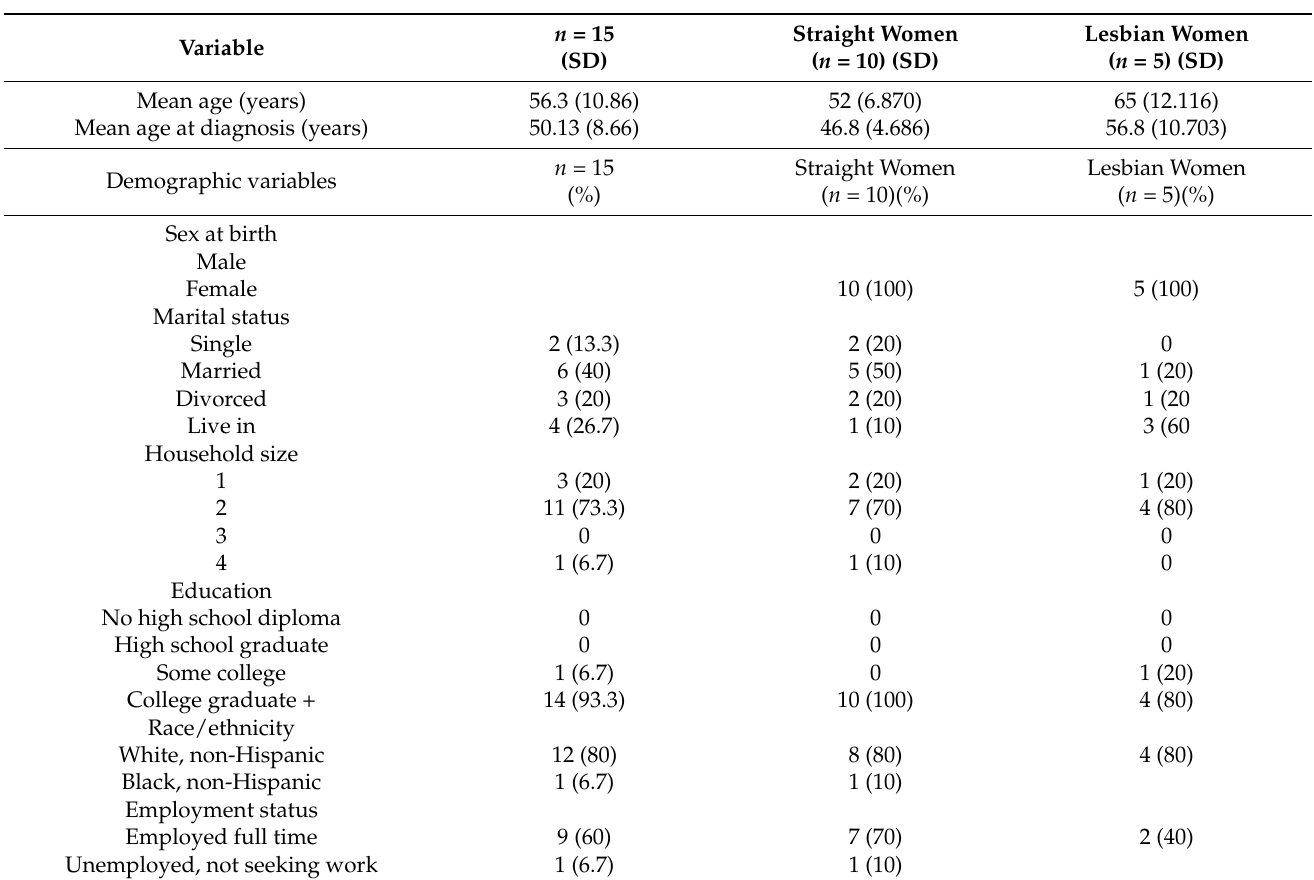
Table 1. Demographic characteristics of respondents ( n =